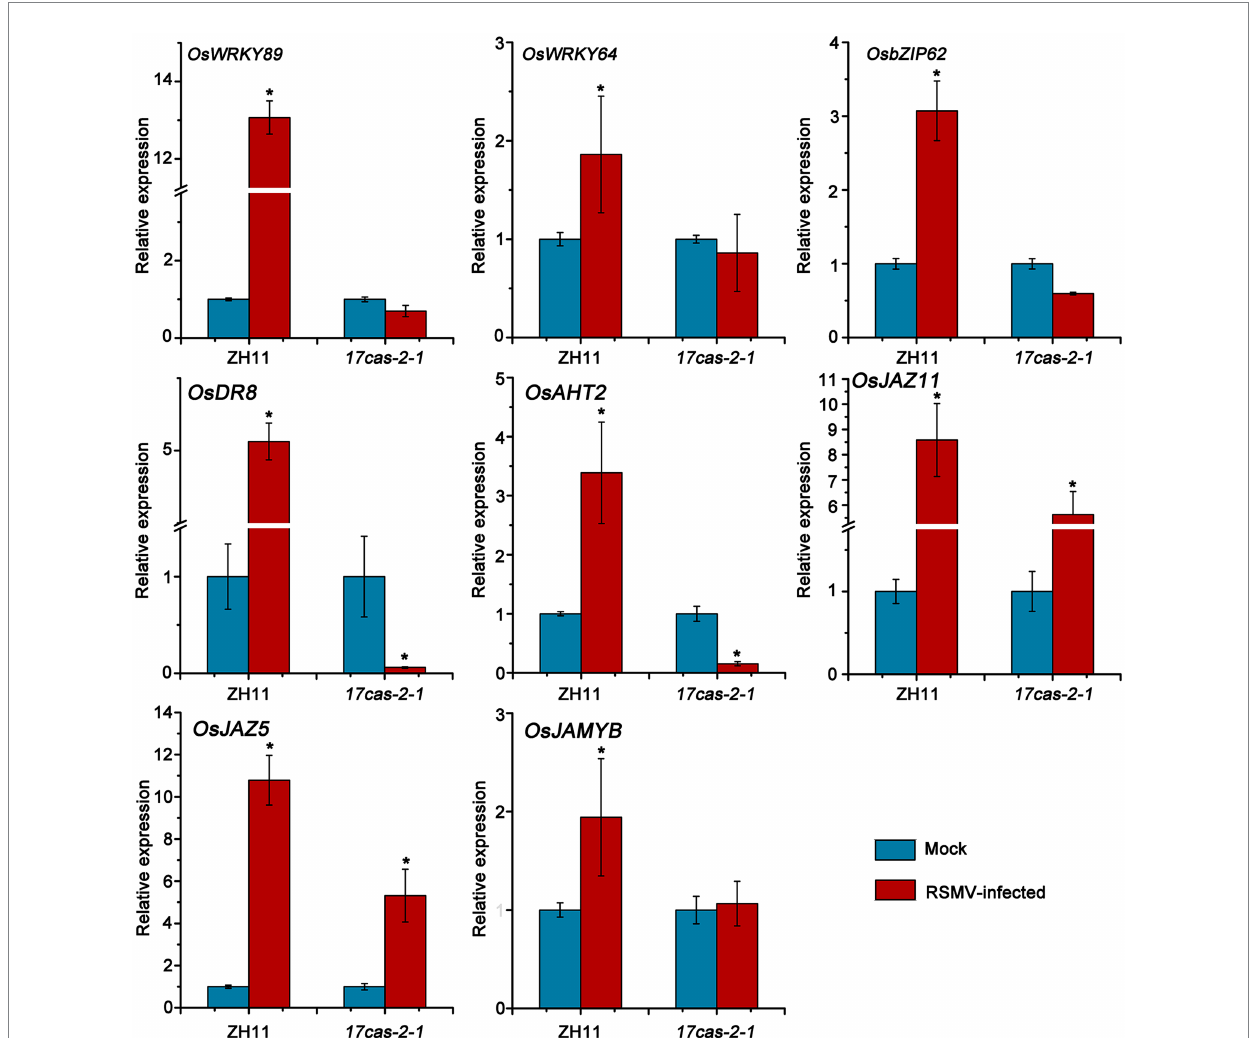
FIGURE 5 Results of RT-qPCR to verify the expression levels of 8 defense response-related genes in RSMV infected ZH11 and OsARF17 mutant plants. * at the top of columns indicate significant differences ( p < 0.05) based on Fisher’s least significant difference tests. UBQ5 was used as the internal reference